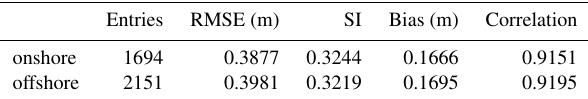
Table 5. Comparison of the data quality, organized by long- and short-fetch situations within the German Bight, for Sentinel-3A SAR. Entries RMSE (m)